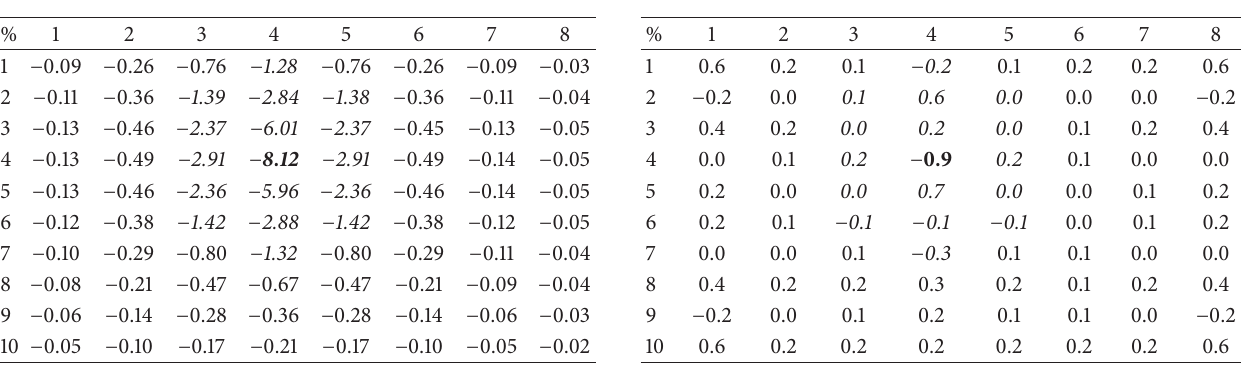
Table 2: Relative temperature error caused by the damaged heater.